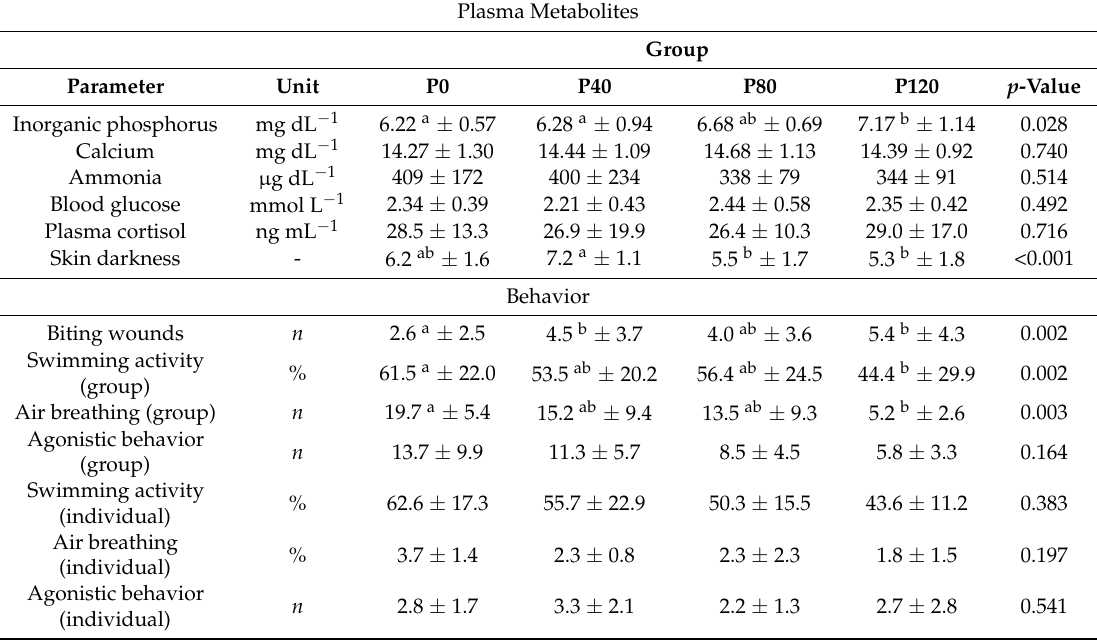
Table 6. Health and welfare indicators—plasma metabolites and skin darkness and behavior of C. gariepinus challenged with different amounts of dissolved phosphate (means ±